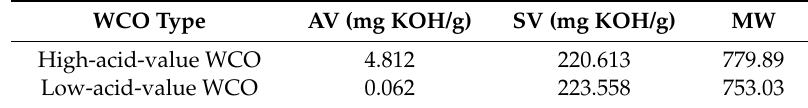
Table 1. Properties of high-acid-value WCO and low-acid-value WCO. WCO